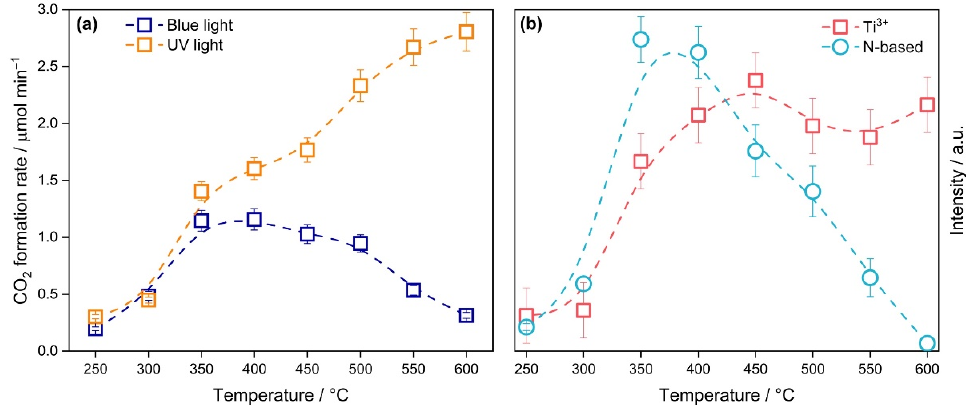
Figure 8. Effect of calcination temperature on the photocatalytic activity ( a ) and intensity of EPR signals ( b ) of the TiO 2 -N sample.